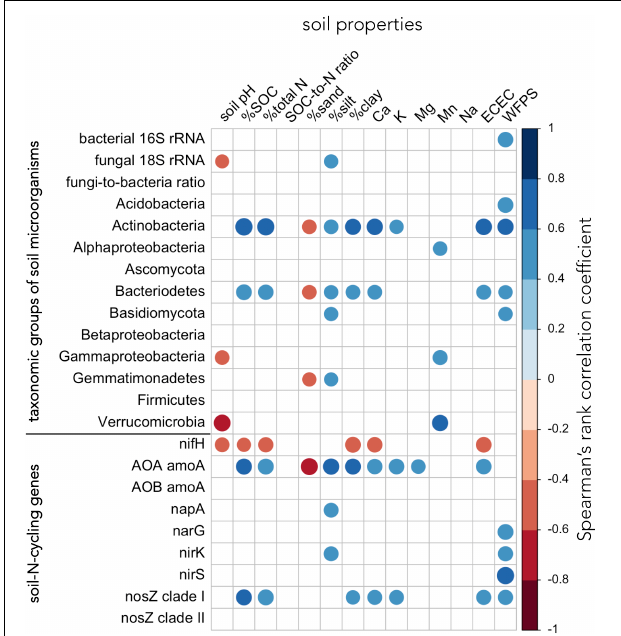
FIGURE 7 | Relationships between groups of soil microorganisms, soil-N-cycling genes, and soil properties. Relationships were assessed using Spearman’s rank correlation test across all replicate plots of paired temperate agroforestry and monoculture croplands in all three soil types ( n = 60). The diameter of the circles is proportional to the absolute magnitude of the correlation coefficient. Only statistically significant correlations at p < 0.05 are shown. AOA = ammonia-oxidizing archaea, AOB = ammonia-oxidizing bacteria, ECEC = effective cation exchange capacity, SOC = soil organic carbon, WFPS = water-filled pore